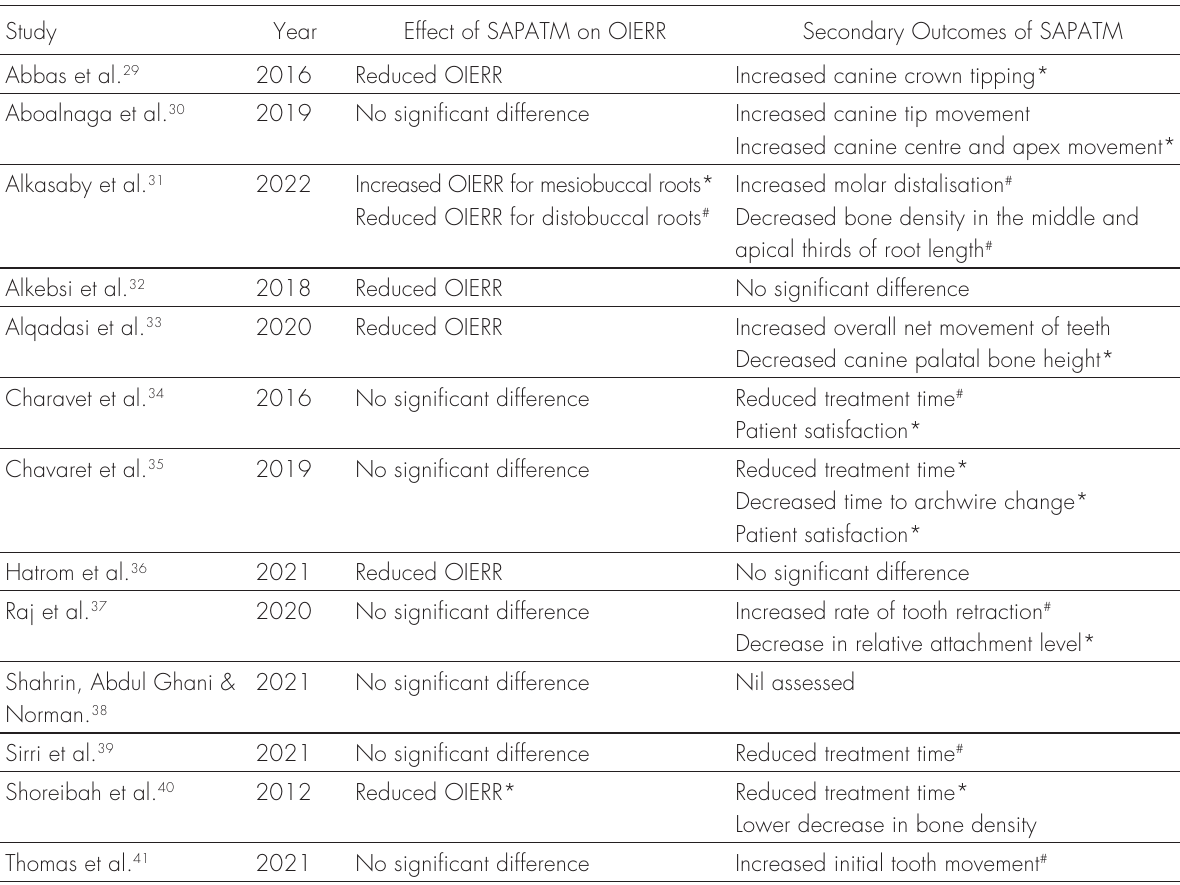
Table III. Outcomes of Included Studies.